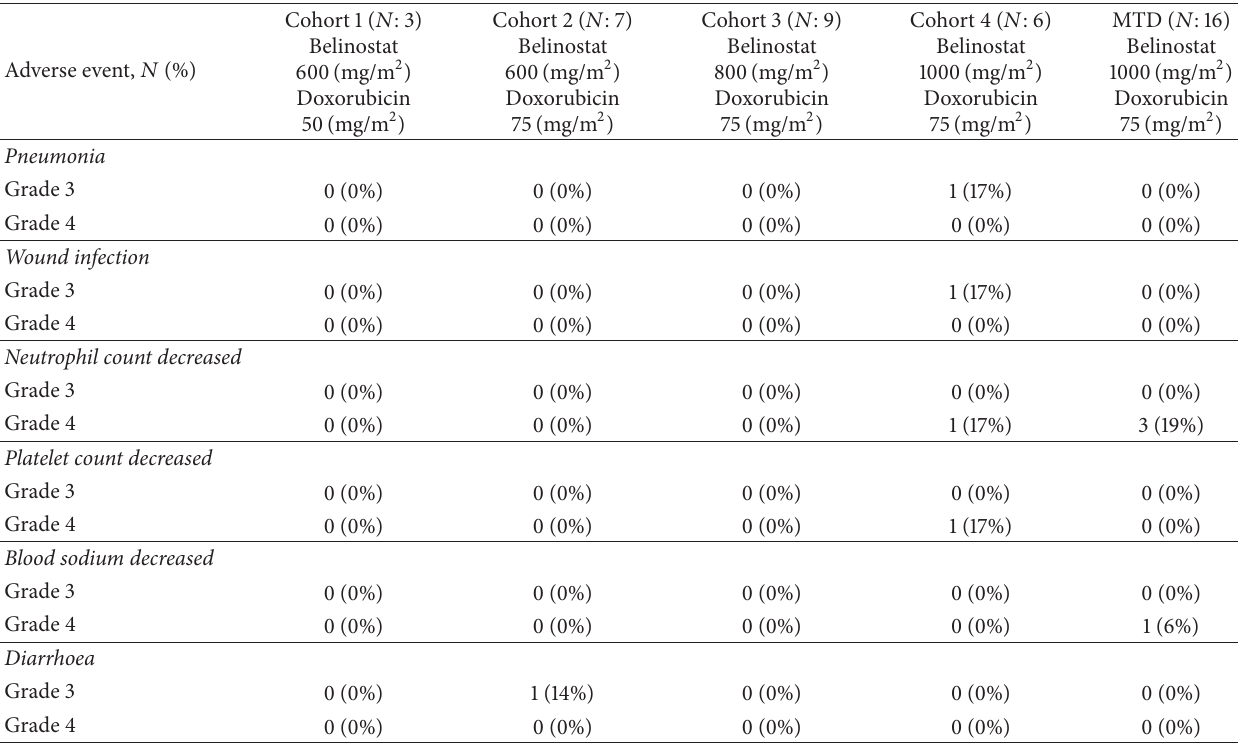
Blood sodium decreased